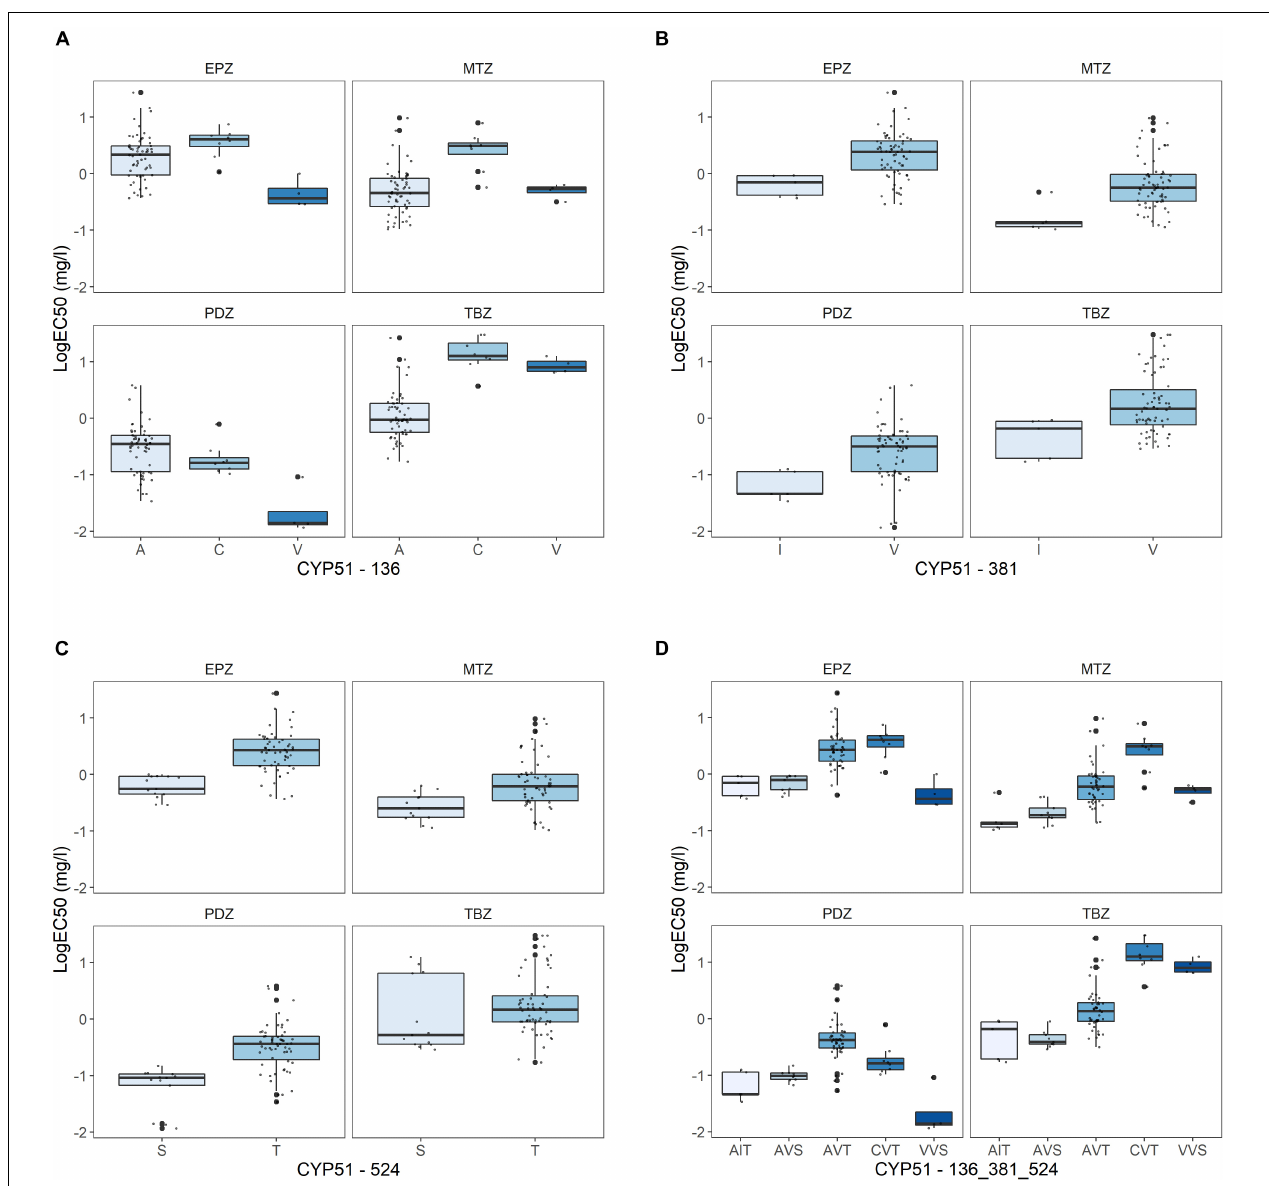
FIGURE 4 | Effect of alterations in the CYP51 at position (A) 136, (B) 381, (C) 524, and (D) at all three positions (the specific amino acid at 136, 381, and 524 in sequential order) on sensitivity towards epoxiconazole (EPZ), metconazole (MTZ), prothioconazole-desthio (PDZ), and tebuconazole (TBZ). Sensitivity presented as LogEC50 (mg l − 1 ), with outliers highlighted in bold.